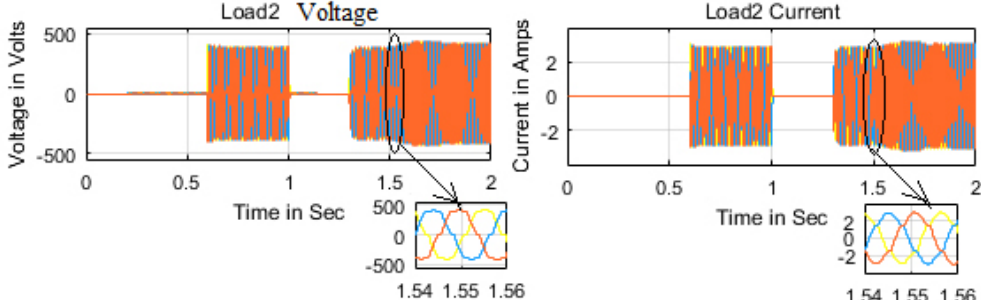
Figure 24. Load2 Voltage & Current.